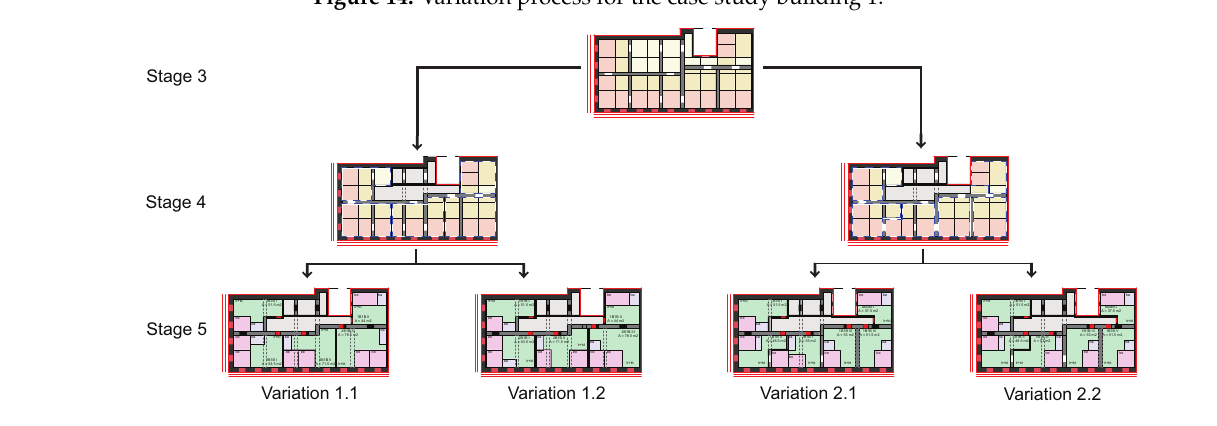
Figure 14. Variation process for the case study building 1.